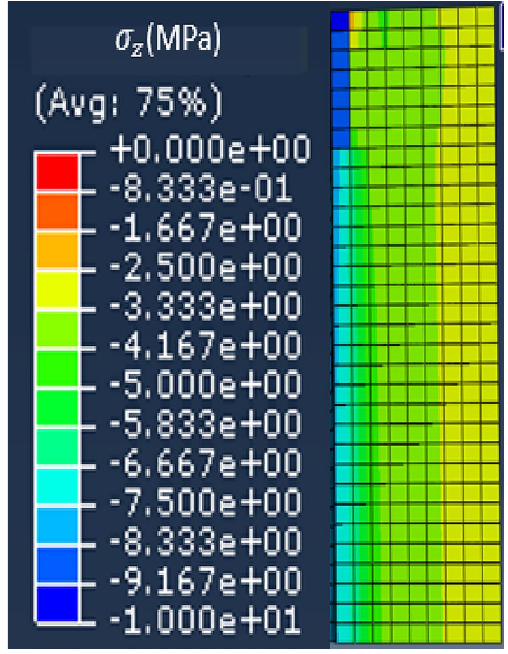
Figure 8. Axial mechanical stress distribution - Homogeneous case.